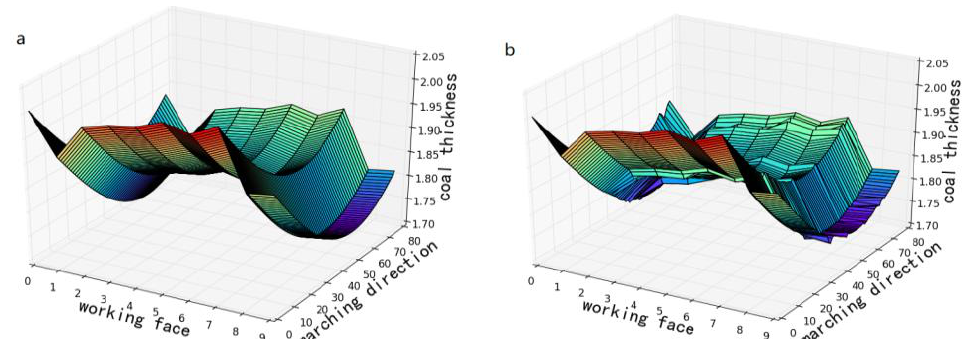
Figure 10. Three-dimensional (3D) visualization of the coal seam surface obtained from the simulated experiment: ( a ) real surface and ( b ) prediction surface.